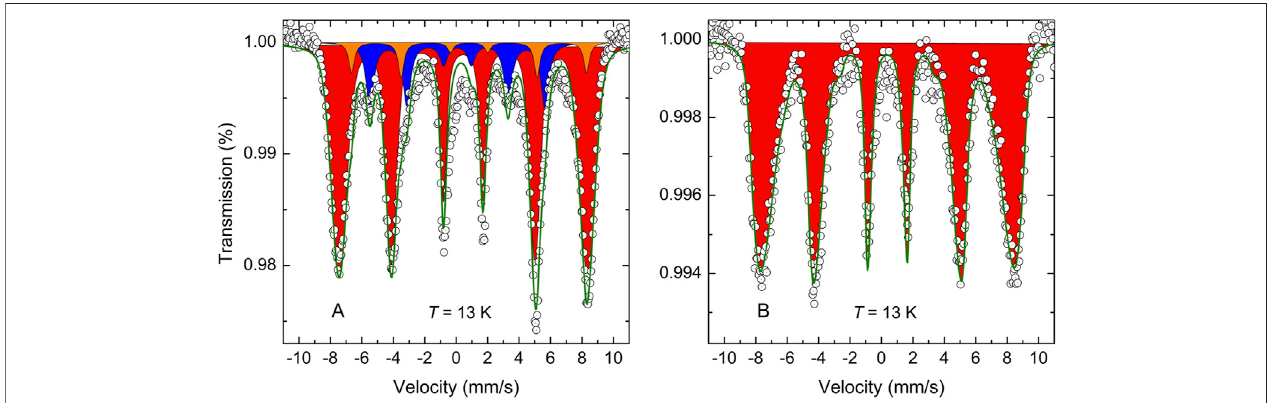
FIGURE4 | Thelow-temperature (13 K) 57 Fe Mössbauer spectra of the2 SrO + α -Fe + MoO 3 mixture milled for 240 min (A) before and (B) after thermal treatment at 923 K for 30 min in air. The spectra correspond to (A) the partly synthesized Sr 2 FeMoO 6 and (B) the completely synthesized Sr 2 FeMoO 6 . The orange and red subspectra are associated with Fe cations in the ordered and anti-site disordered regions of Sr 2 FeMoO 6 double perovskite, respectively. The blue subspecrum corresponds to α -Fe.